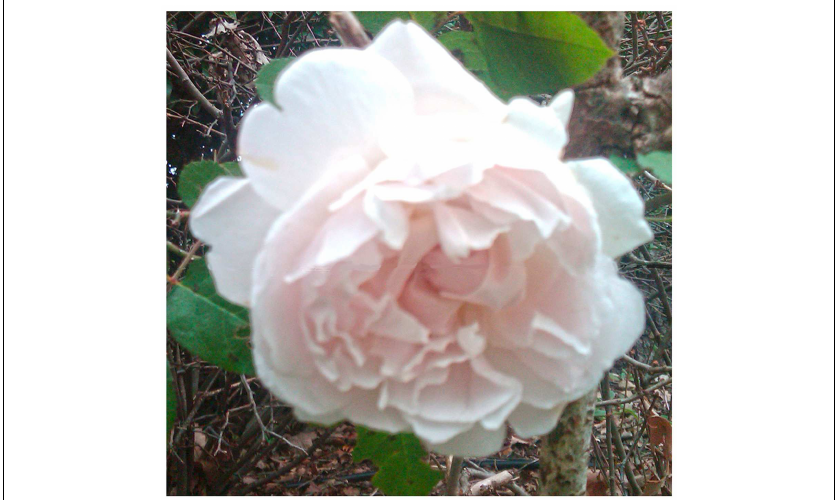
FIGURE 1 |The Rose sent by Mel : the Redouté Rose was named after Joseph-Pierre Redouté, a Belgian artist who painted roses for Marie Antoinette, then for Josephine Bonaparte, “the rarest and most beautiful plants obtainable.” He was immortalized through his timeless inspiration of others. Just like Mel